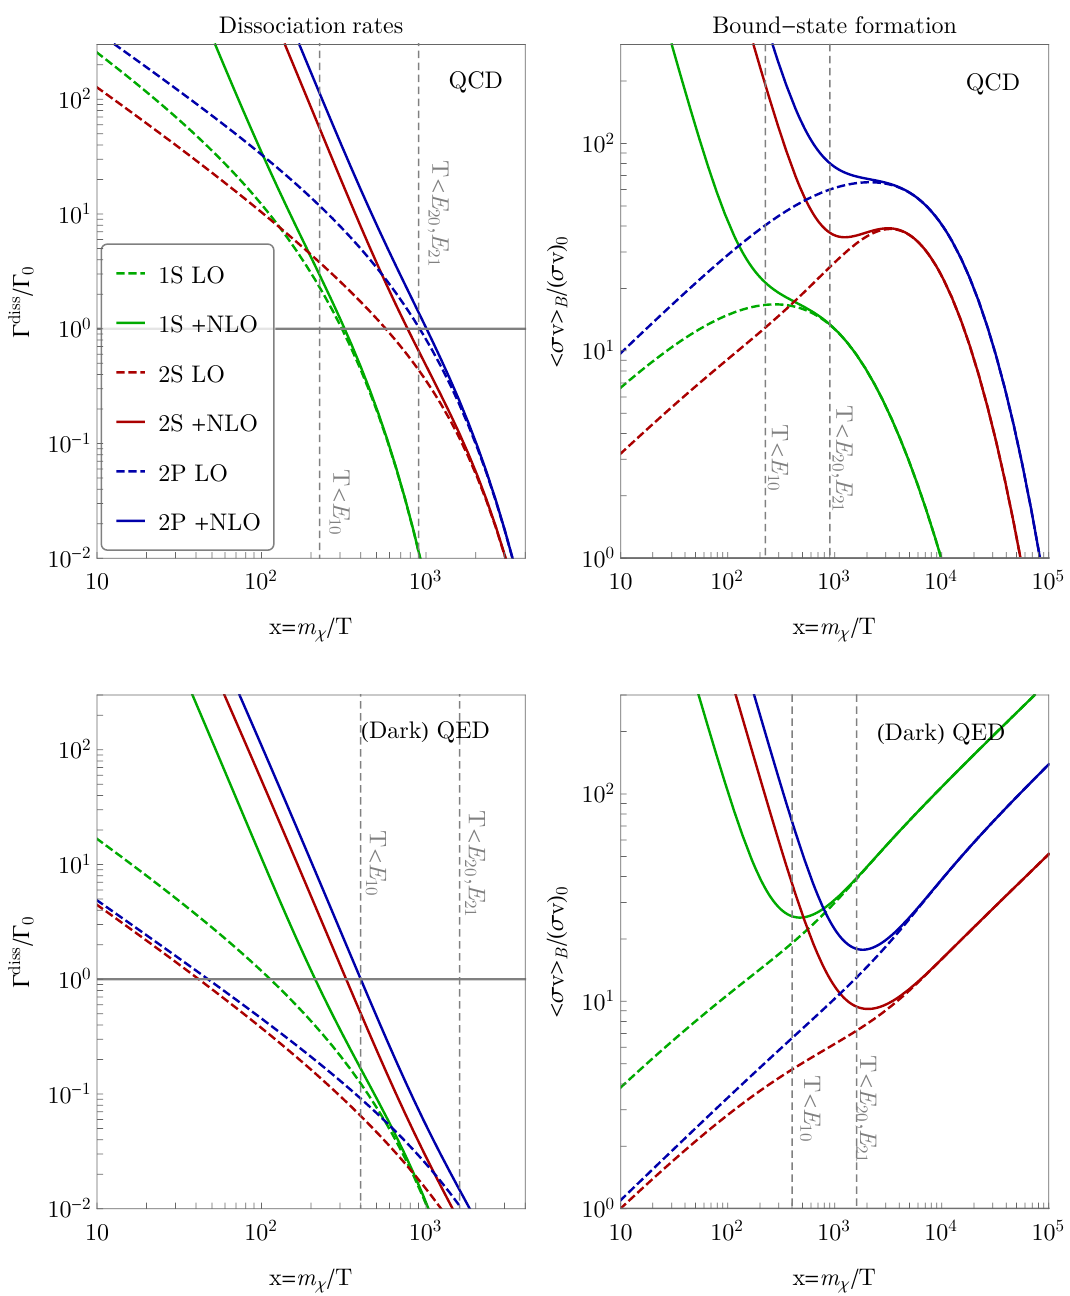
Figure 9. Bound state dissociation rates and thermally averaged recombination cross sections for two cases: (1) QCD with α = 0 . 1 , N c = 3 , n f C ( N ) = 3 (upper row) and (2) QED with n f C ( N ) = 3 (lower row). Dissociation rates are normalized by Γ 0 = α 5 m χ / 2 , while BSF cross sections are normalized by ( σv ) 0 = πα 2 /m 2 χ . Since the potential for S ( χ ¯ χ ) adj is repulsive, the BSF cross section for QCD drops at a lower